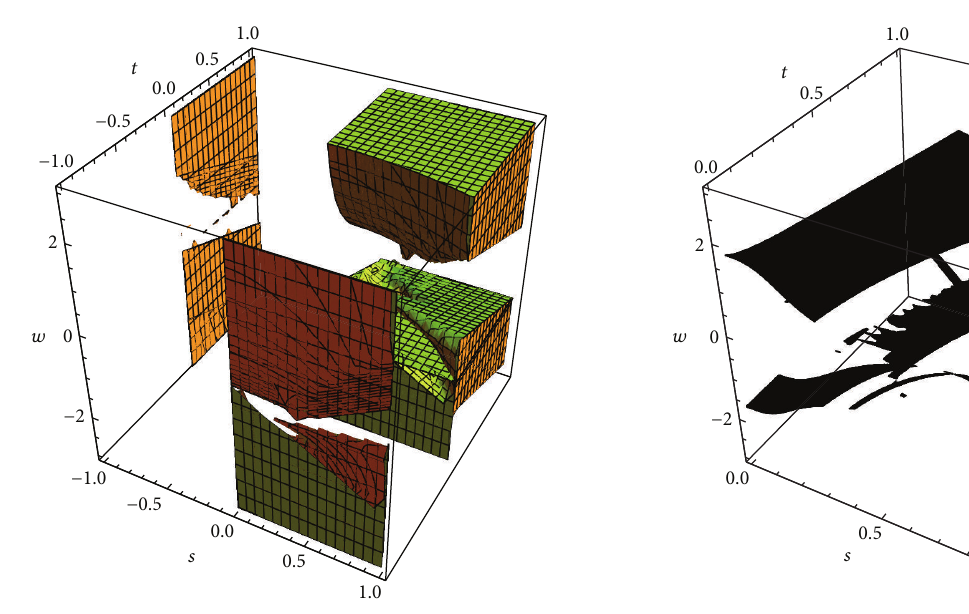
Figure 5: CC region where both 𝜇 1 and 𝜇 2 are positive subject to the constraints 𝐶(𝑠,𝑤, 𝑡) and 𝐶 ∗ (𝑠,𝑤,𝑡) .